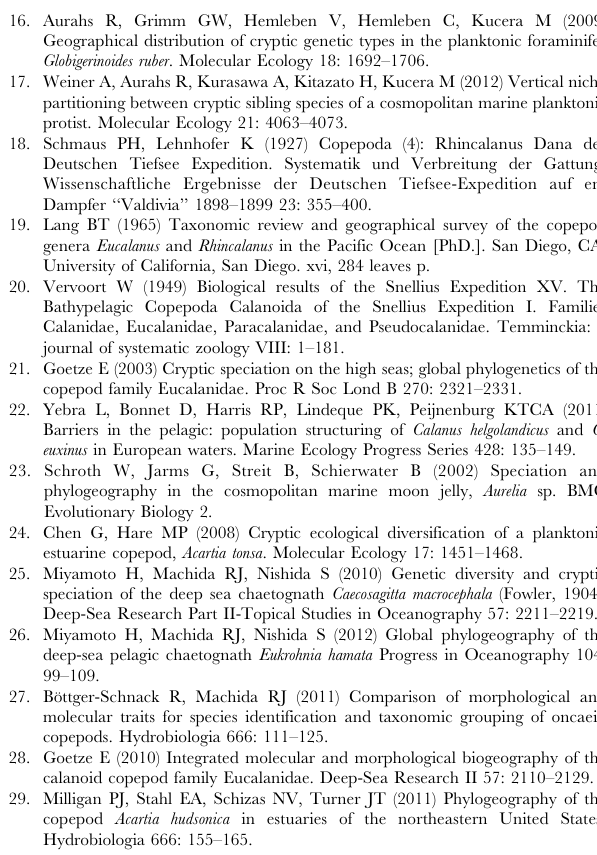
Figure S1 Distribution map for clades C, D, I and E. The number of specimens (n) for each site is given in parentheses beside the symbol. Small, open circles indicate sample locations that did not include any specimens of these clades (absence). Colors and symbols for each clade as indicated in the legend. (TIF) Figure S2 Distribution map for clades J, K, L, and H. The number of specimens (n) for each site is given in parentheses beside the symbol. Small, open circles indicate sample locations that did not include any specimens of these clades (absence). Colors and symbols for each clade as indicated in the legend. (TIF) Figure S3 Bayesian phylogeny of P. piseki – P. gracilis clades B and F, incorporating sequences from cloning experiments and other problematic data from genomic DNA amplifications. (A) Bayesian phylogeny of clade B, (B) Bayesian phylogeny of clade F. Green text = sequences cloned from genomic DNA amplifications. Blue text = mtCOII amplifications (376-bp) with primers PLPI- COIIFC & COIIR10 that were used to determine the clade membership of animals yielding multiple products in PCR. NUMTs (premature stop codon) are highlighted in grey. Bold